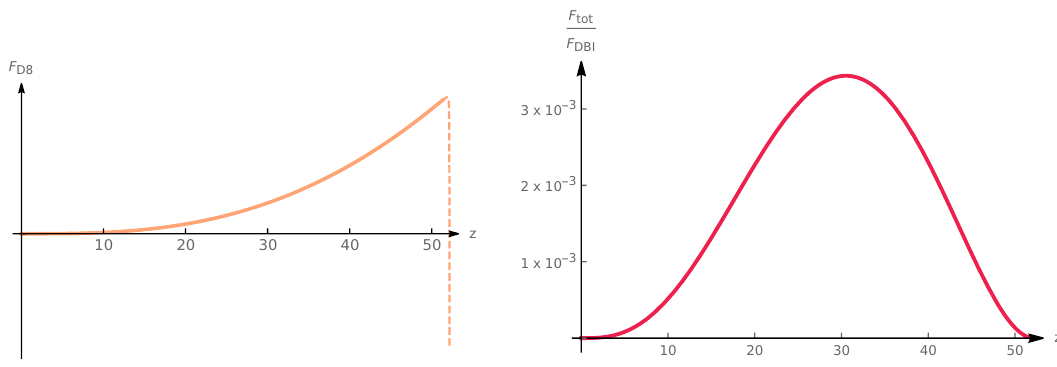
Figure 2 . The left figure (orange) gives the total force on a probe D8, computed as the sum of the DBI and WZ forces. As z approaches z 52 , the force drops and appears to reach a non-vanishing 0 ∼ negative value (dashed), but we believe that this residual result is most likely a numerical artifact from the cancellation of the two diverging contributions. This can be seen from the right (red) figure, which gives the ratio between the total force and the gravitational attraction: F tot . As F DBI explained in the main text, the behavior near z ∼ z has to be taken with a grain of salt, since 0 corrections to the probe action are not negligible in the strongly-coupled